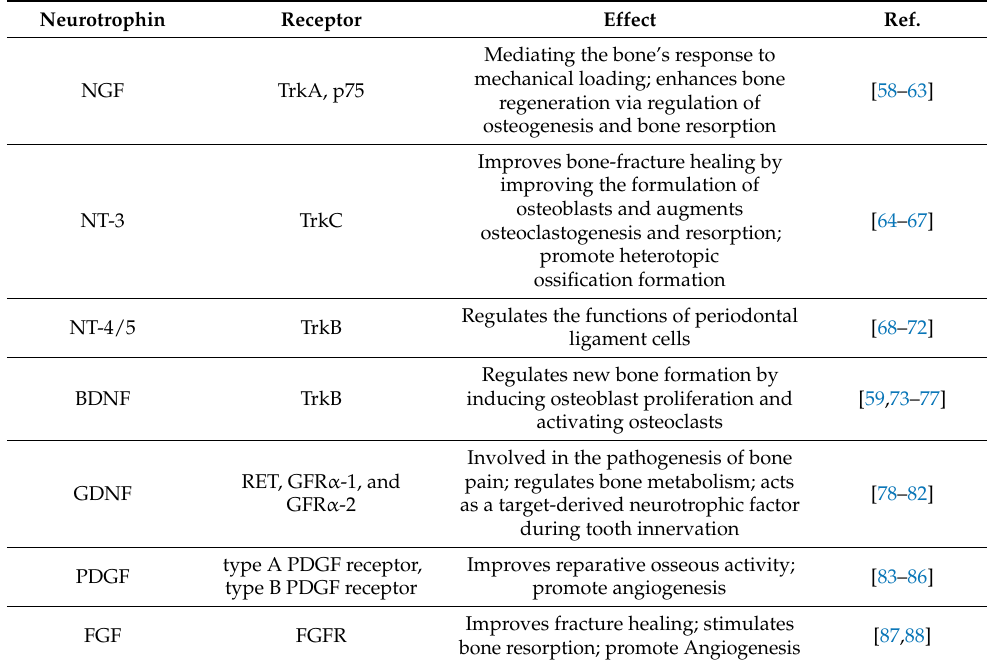
Table 1. The receptors and effect of neurotrophins on bone. Neurotrophin Receptor Effect